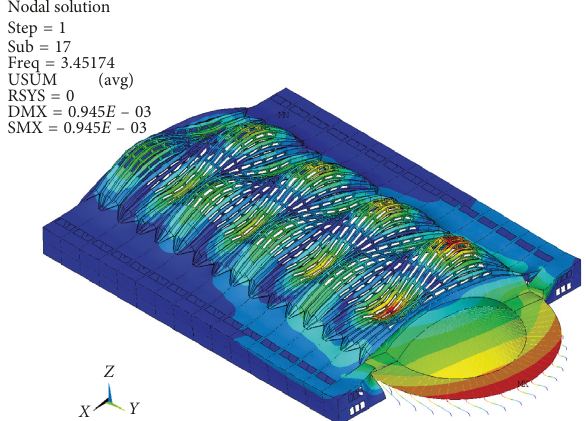
Figure 10: Mode 17 of Hall B (apse